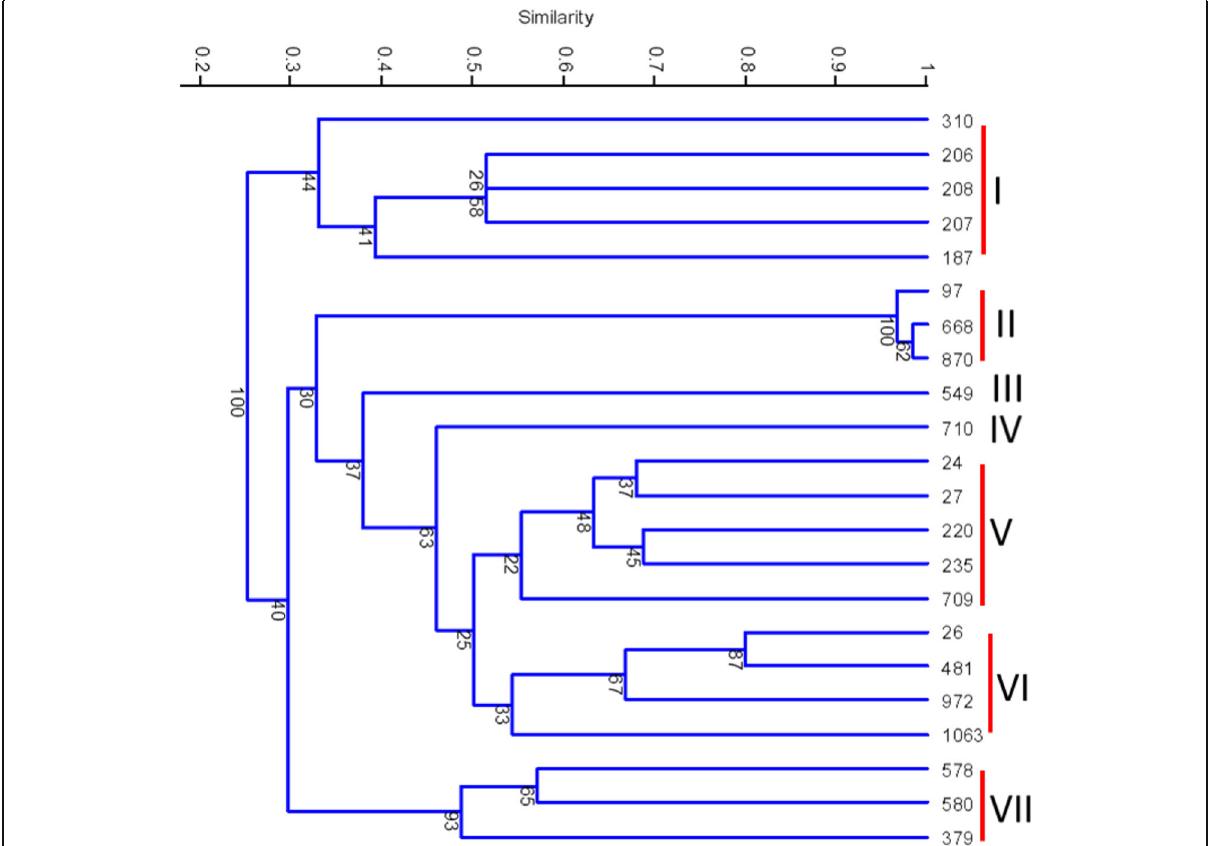
Fig. 1 Dendrogram of the genotypes of C. pepo from different regions of Saudi